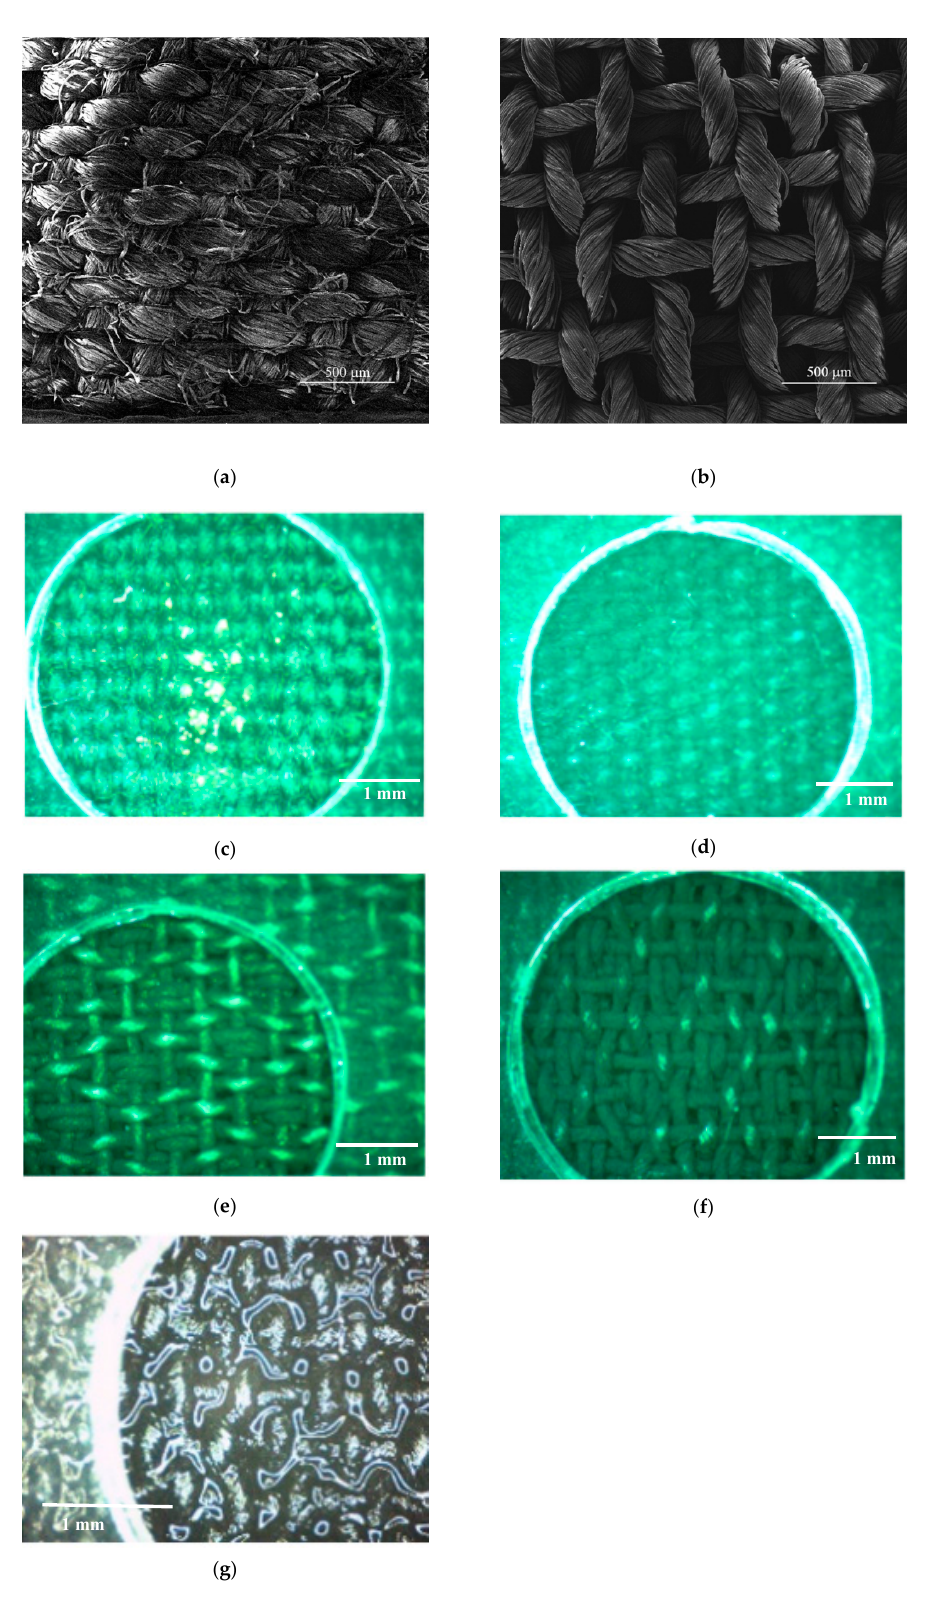
Figure 4. ( a ) SEM image of CO fabric, ( b ) SEM image of PET fabric, and magnified views of the microfluidic platforms with ( c ) CO-PANI / TiO 2 -1; ( d ) CO-PANI / TiO 2 -2; ( e ) PET-PANI / TiO 2 -1; ( f ) PET-PANI / TiO 2 -2; and ( g ) PET-PANI / TiO 2 -1 with injected artificial